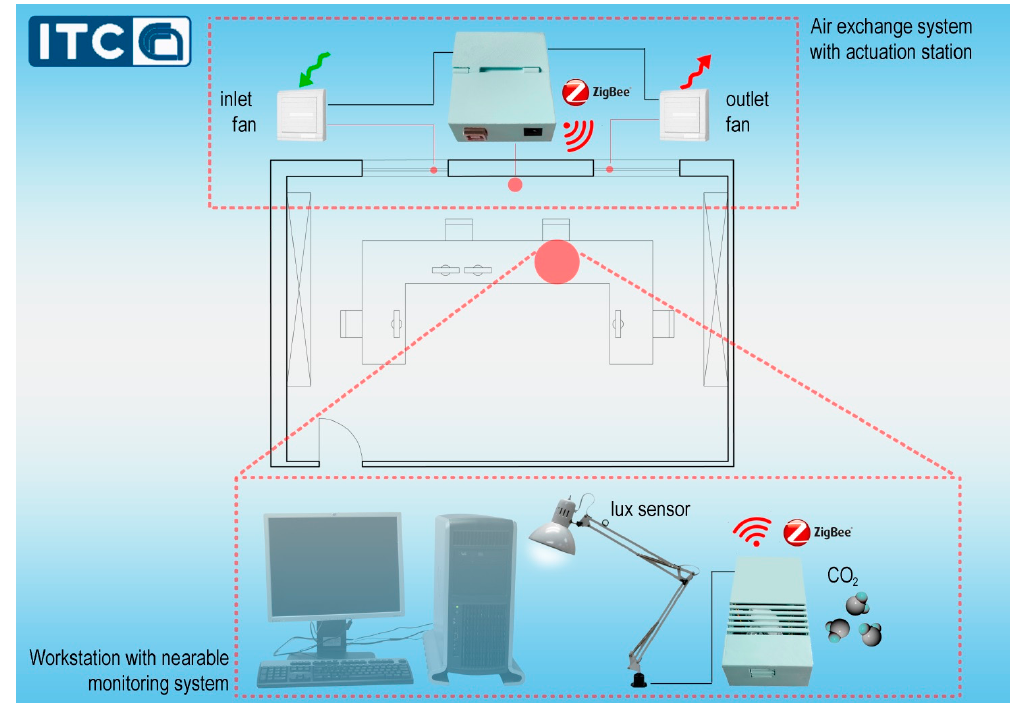
Figure 1. Hardware layout in a real case study.